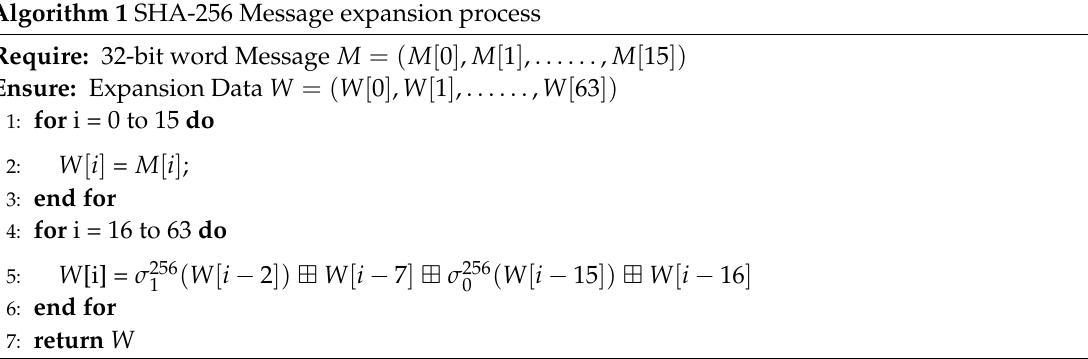
Algorithm 1 SHA-256 Message expansion process